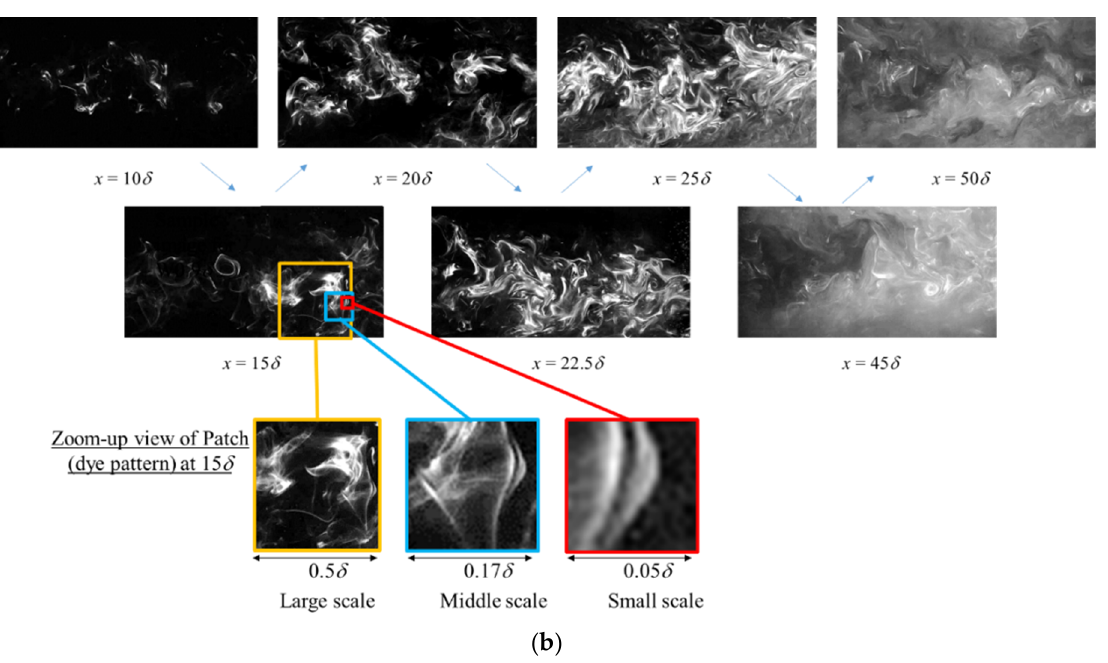
Figure 1. ( a ) Schematic of experimental setup; YAG = yttrium aluminum garnet. ( b ) Samples of original images (1.8 δ × 3.6 δ ) including multi − scale patches in a dye pattern. Flow direction is from left to right.